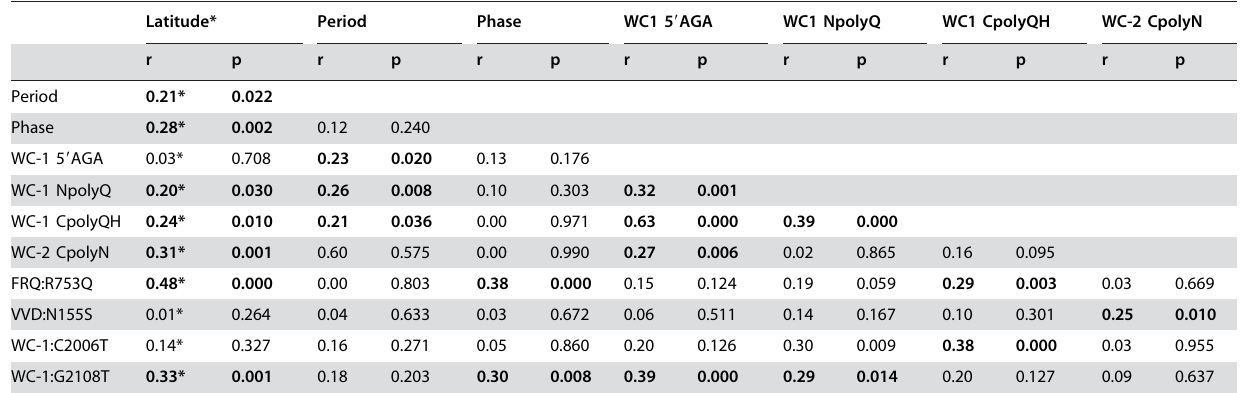
Table 1. Associations between genotype, phenotype and circadian parameters across Neurospora crassa accessions at 25 u C .